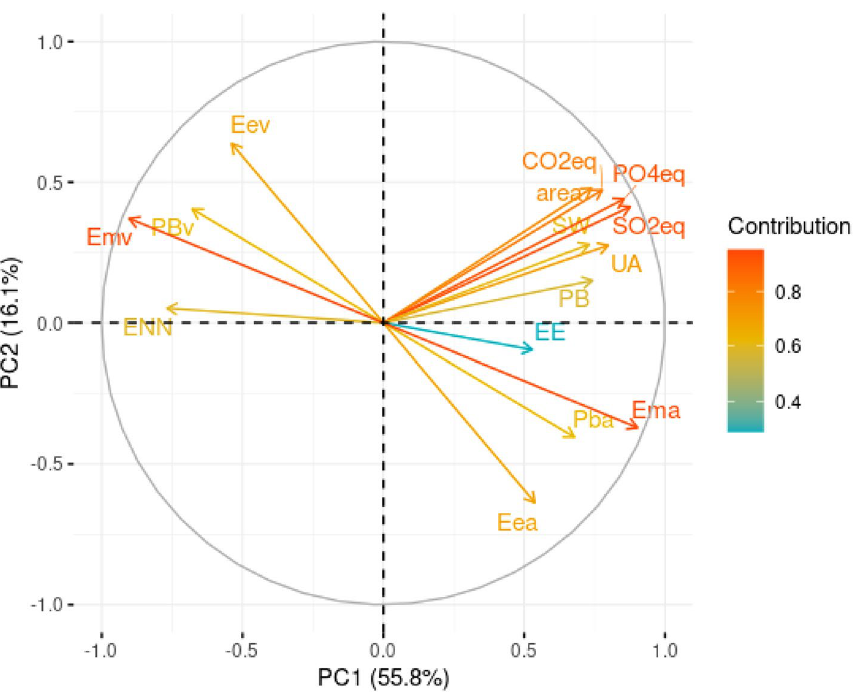
Figure 4. Principal component analysis (PCA) of first principal component (PC1) versus second principal component (PC2) of diets for dogs. ENN nitrogen-free extract, PBv protein from vegetable sources, Emv metabolizable energy from vegetable sources, Eev fat from vegetable sources, CO2eq carbon dioxide equivalent, area land use, PO4eq phosphate equivalent, SW stress-weighted water usage, SO2eq sulphur oxide equivalent, UA freshwater withdrawals, PB protein content, EE fat content, Ema metabolizable energy from animal sources, Pba protein from animal sources, Eea fat from animal